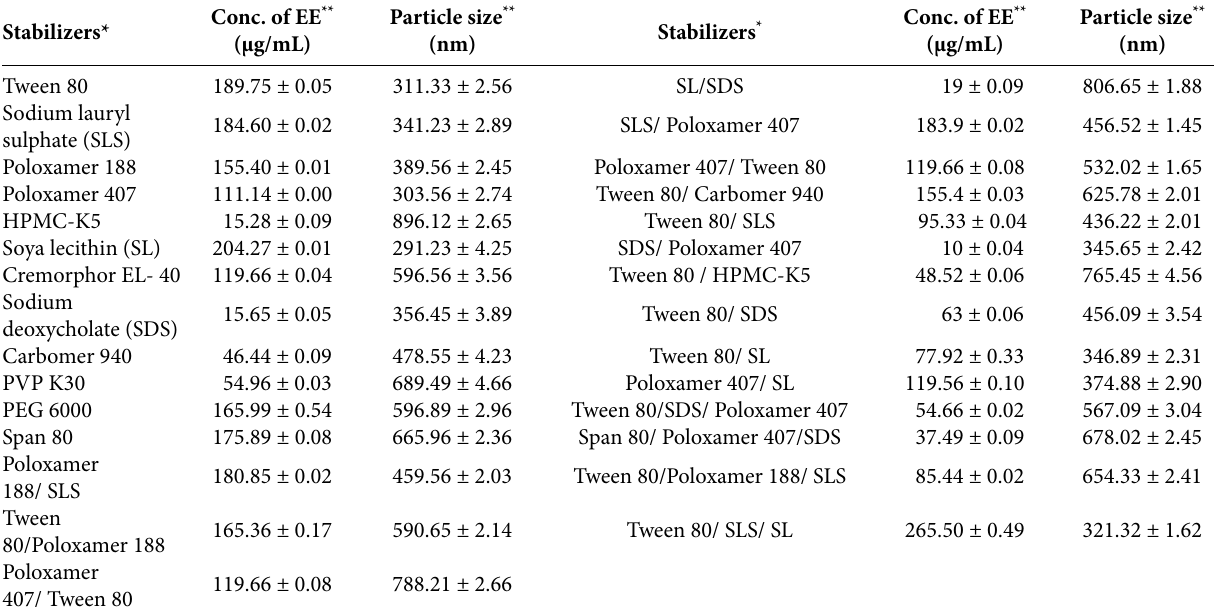
Table 4. Suspending concentrations and particle size of ethinyl estradiol in different stabilizer systems for formulation of nanosuspension.